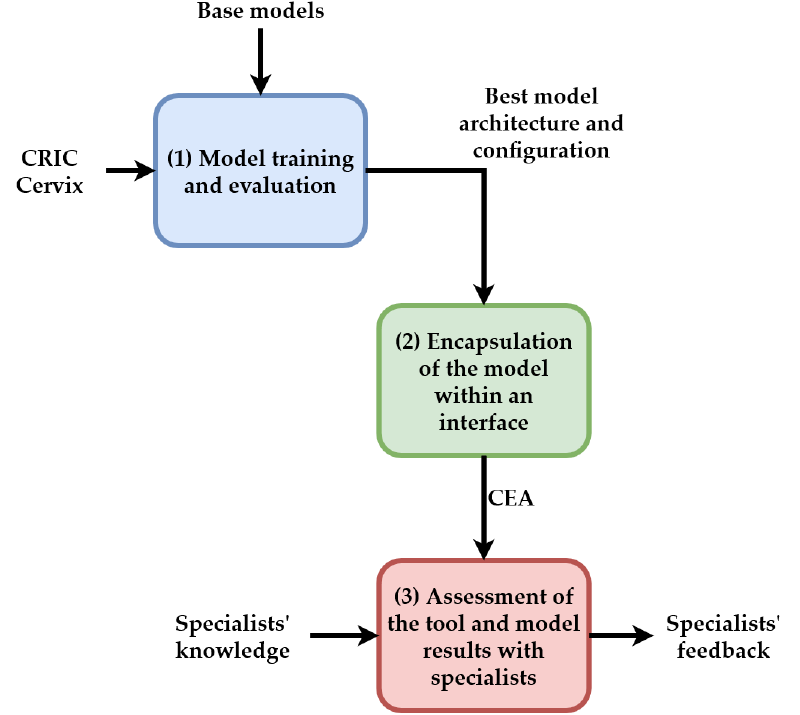
Figure 2. Our proposal